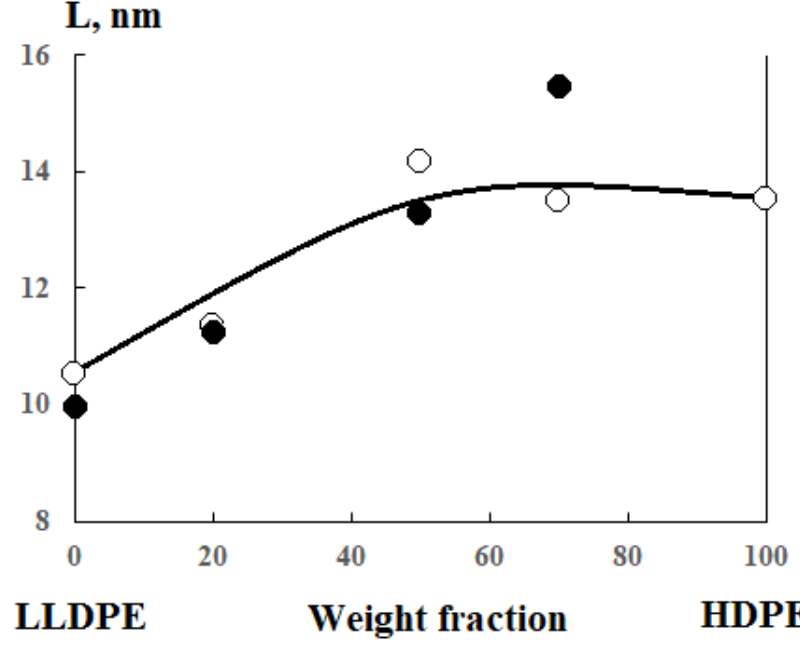
Figure 6. Concentration dependence of crystallite sizes in HDPE-1/LLDPE samples from diffracto- gram data (white dots) and DSC data (black dots).